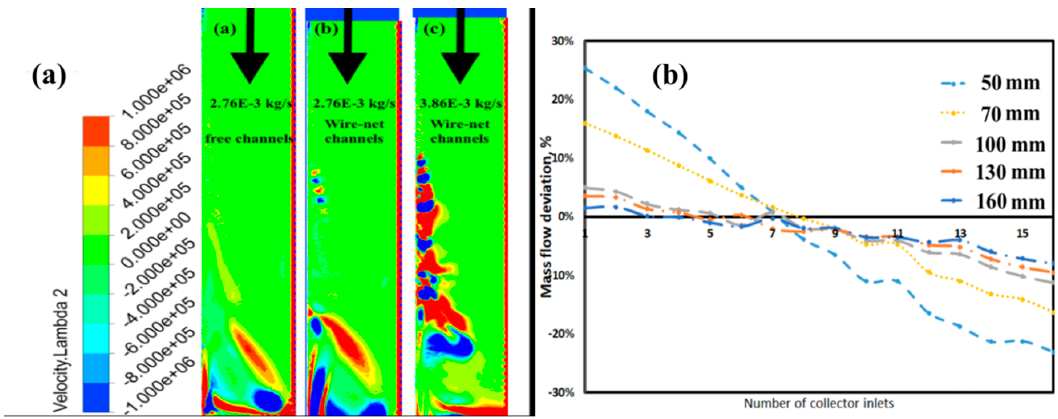
Figure 6. Cylindrical secondary collector performance for various microchannel pressure losses and mass flow rates ( a ); primary collector performance for different heights ( b ) based on a computational study.